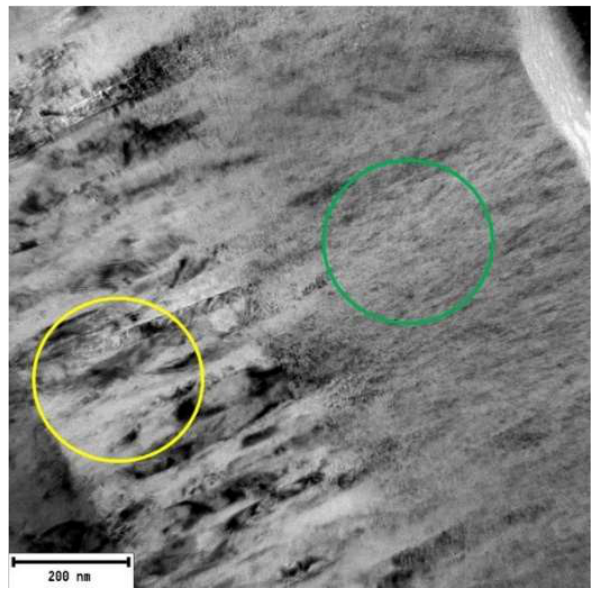
Figure 9. Microstructure of the surface layer with marked points of the performed analyses. Table 5. Element content measured by EDS analysis, results reported in at.%.